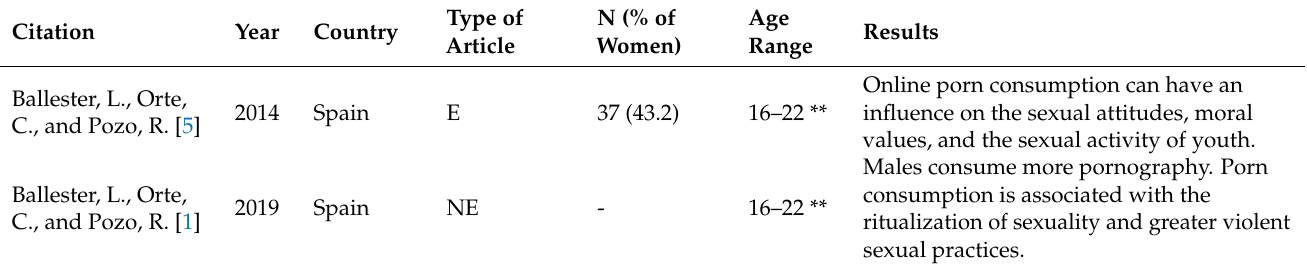
Table 1. Details of studies included in the